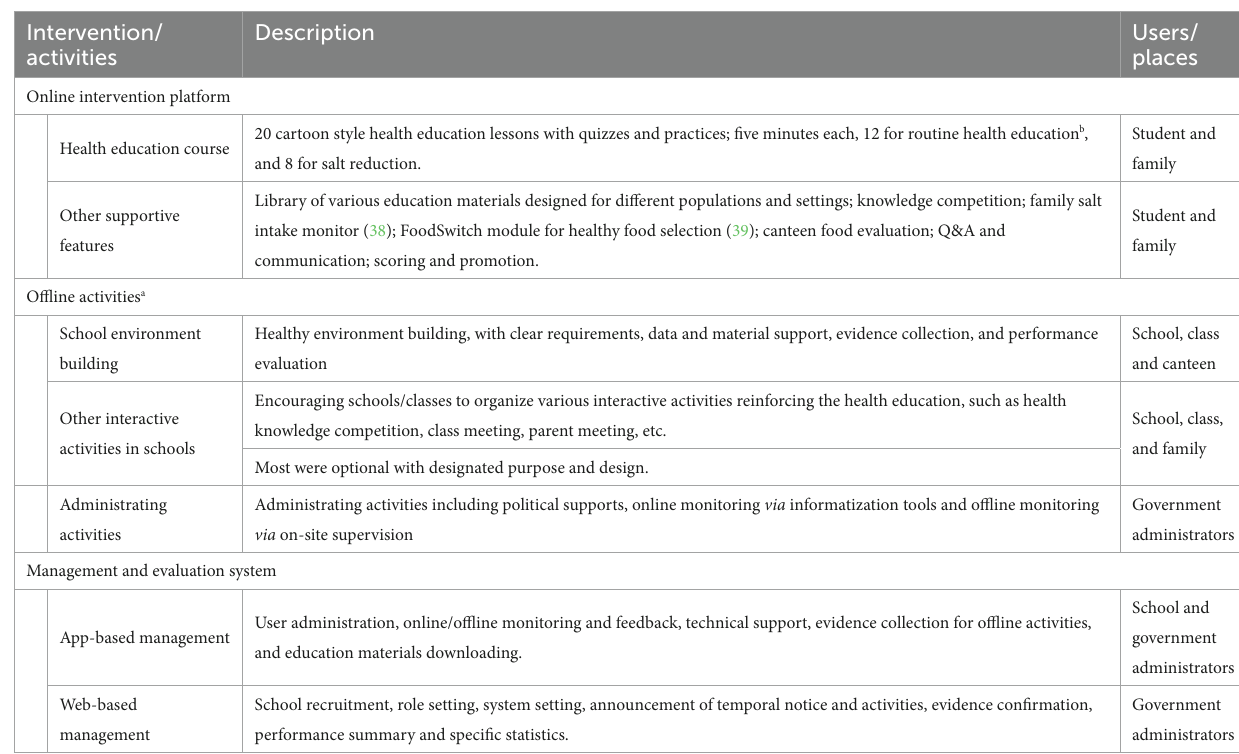
TABLE 1 Outline interventions and activities of